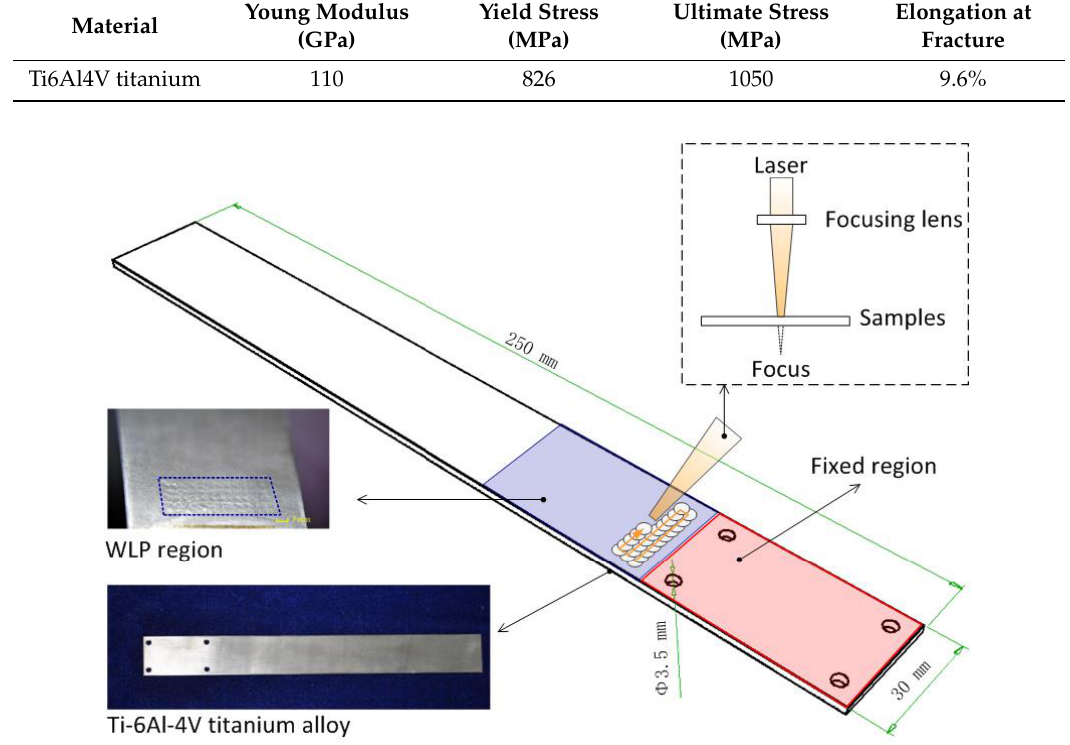
Table 2. Technical parameters of Nd:YAG